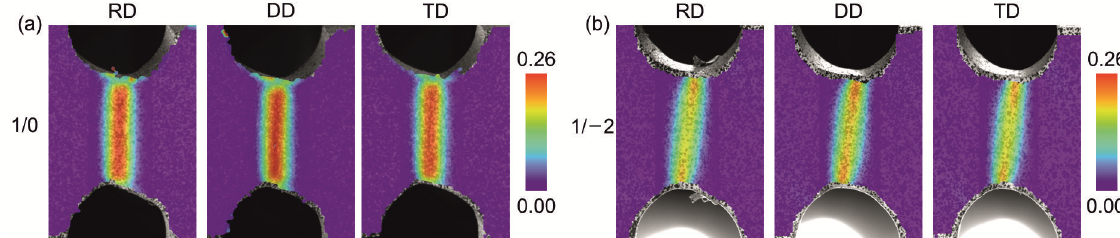
Figure 6. True equivalent von Mises strain distribution: ( a ) load case 1/0 and ( b ) load case 1/–2.